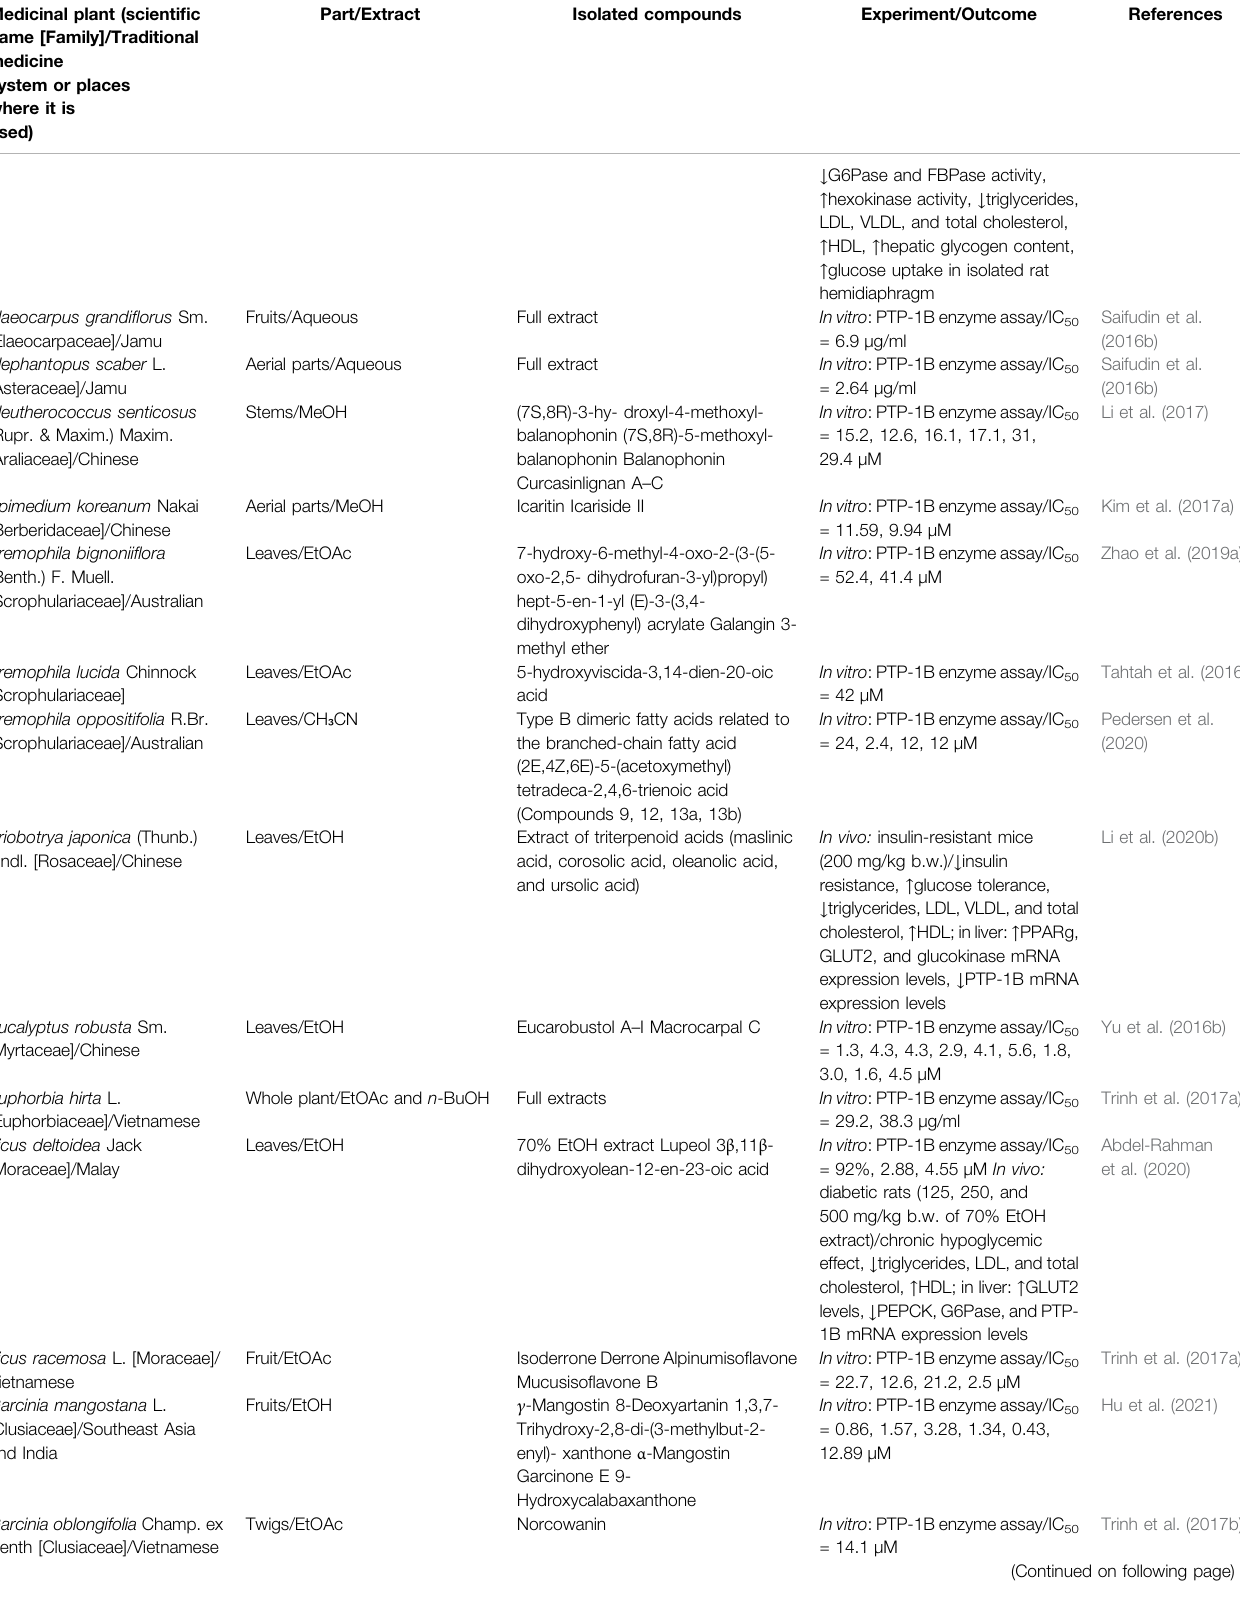
Medicinal plant (scienti fi c name